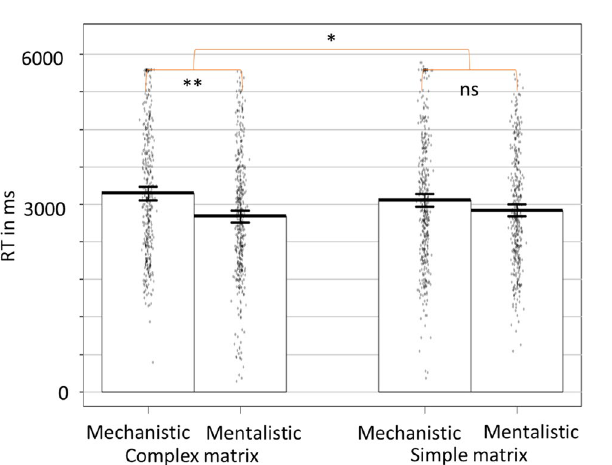
Figure 8. Experiment 4 trial sequence (without the fixation crosses).